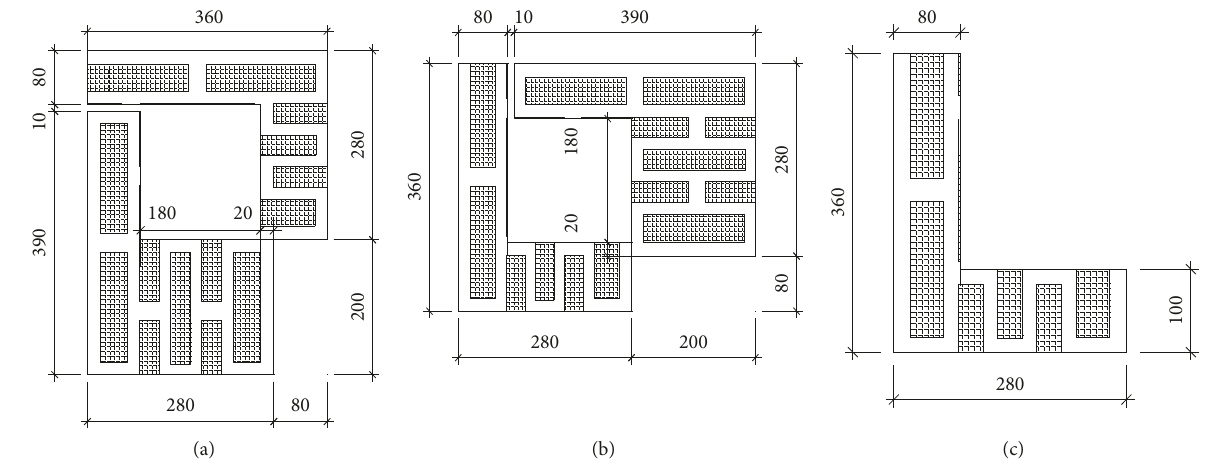
Figure 3: Dimensions of structural columns and ring beams. (a) Odd column construction layer. (b) Even columns construction layer. (c) Ring beam.